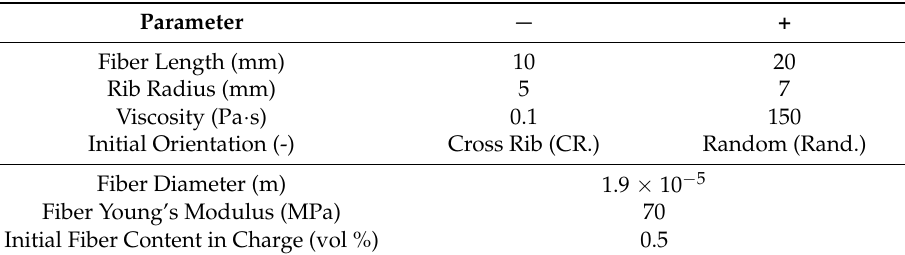
Table 1. Variables for initial design of experiments (DOE).